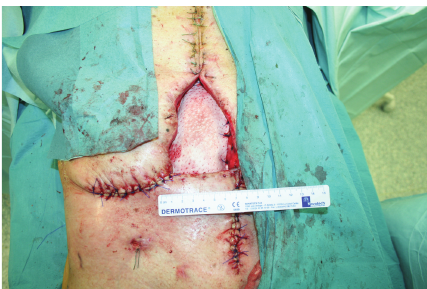
Figure 1: Application of biological mesh over intestinal loops to recreate abdominal